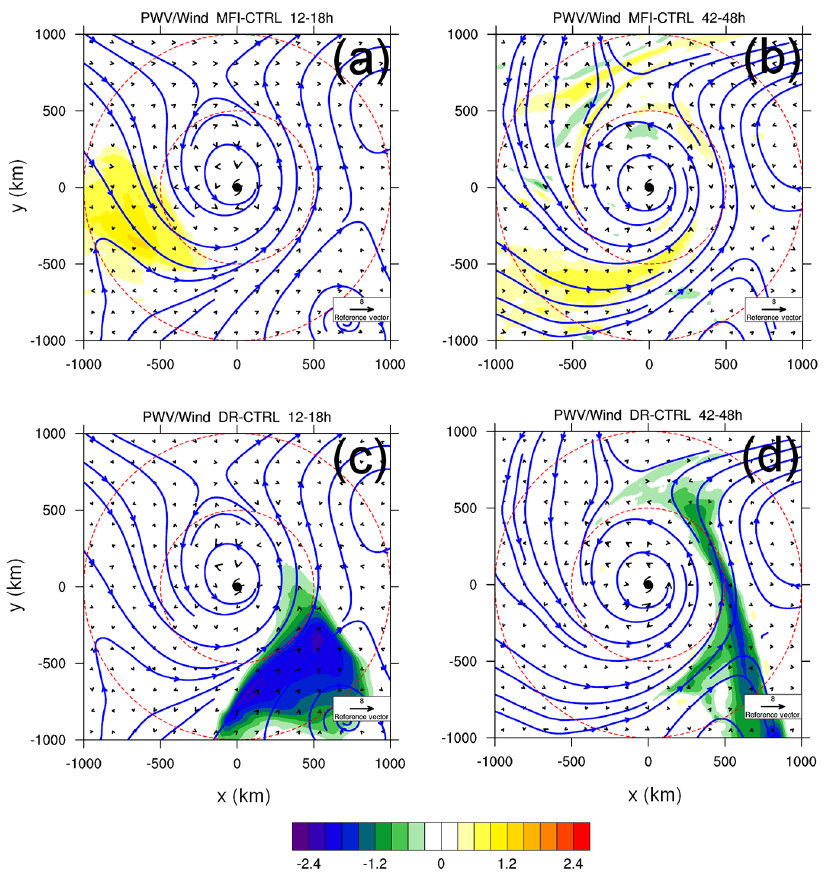
Figure 10. Difference of mean wind vector below 5km and column-integrated PWV (cm) in the storm-following coordinate: (a) MFI- CTRL for 12–18h; (b) MFI-CTRL for 42–48h; (c) DR-CTRL for 12–18h; (d) DR-CTRL for 42–48h. The blue streamline is the translated streamline at the co-moving coordinate for the CTRL case at corresponding time. The hurricane symbol shows the TC center. The dashed red circles represent the radius of 500 and 1000km. All the data are taken from the outer model